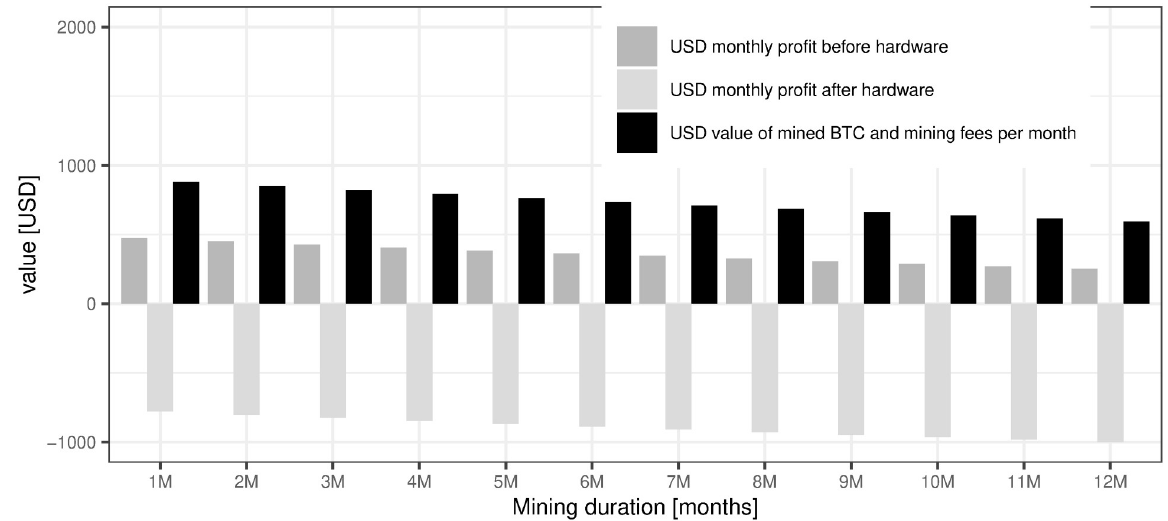
Fig 18. The profitability of mining in USD. Note: The analysis assumes current mining conditions as of 2021/12/03.